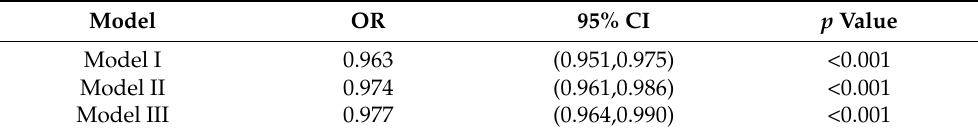
Table 4. The results of the weighted quantile sum regression model. Model